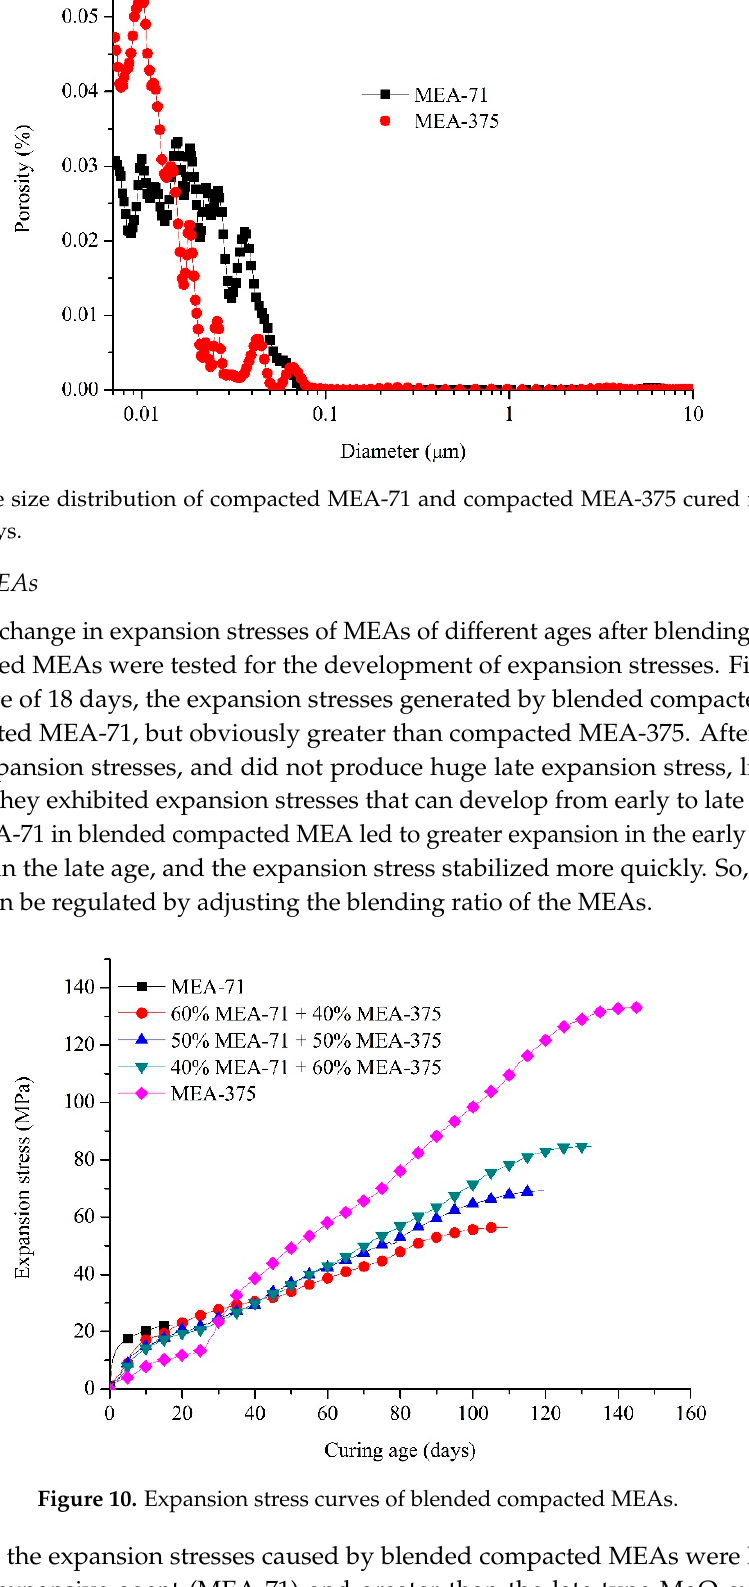
Figure 8. Pore size distribution of compacted MEA-71 and compacted MEA-375 cured in water at 40 °C when the expansion stresses stabilized.